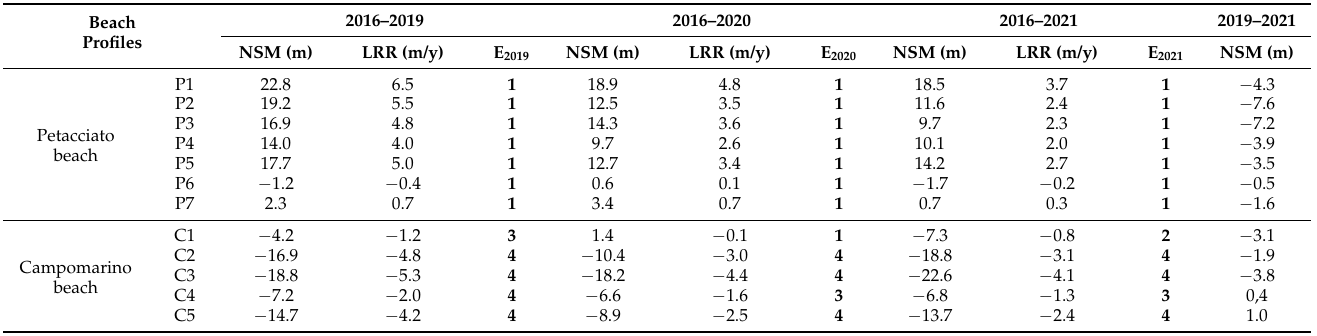
Table 7. NSM and LLR values calculated for profiles P1–P7 and C1–C5 for the periods